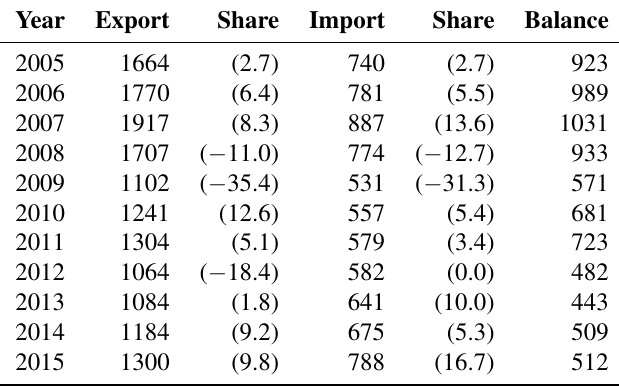
Japan’s trade with Britain (bil. yen/per